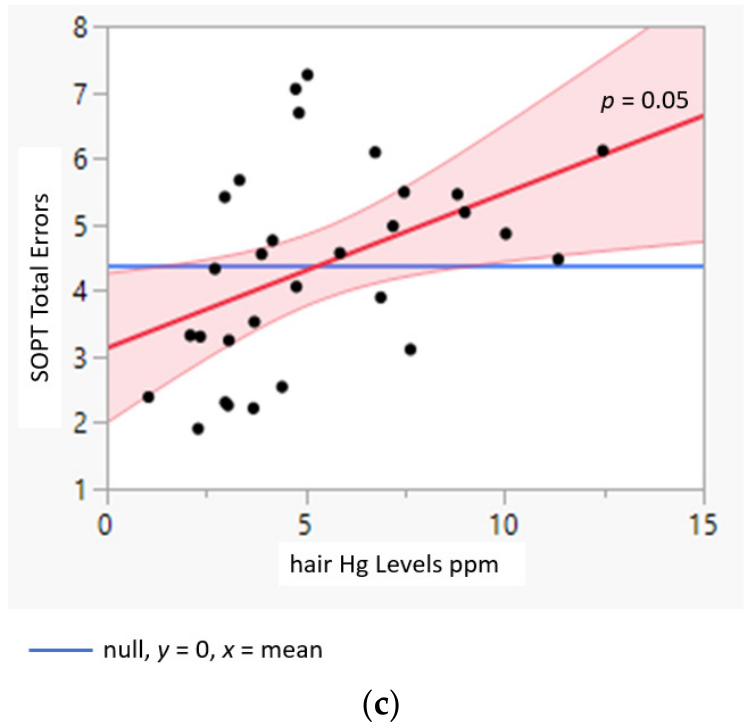
Figure 4. Added variable plots [76] showing the unique effect of a cognitive task (red line and associated 95% CI) as compared to a model assuming the model contains all the other terms (blue line) for each cognitive task but no relationship between the dependent and independent variable. ( a ) Word Span Accuracy vs. Hg, ( b ) Corsi Block Accuracy vs. Hg, ( c ) SOPT Total Errors vs